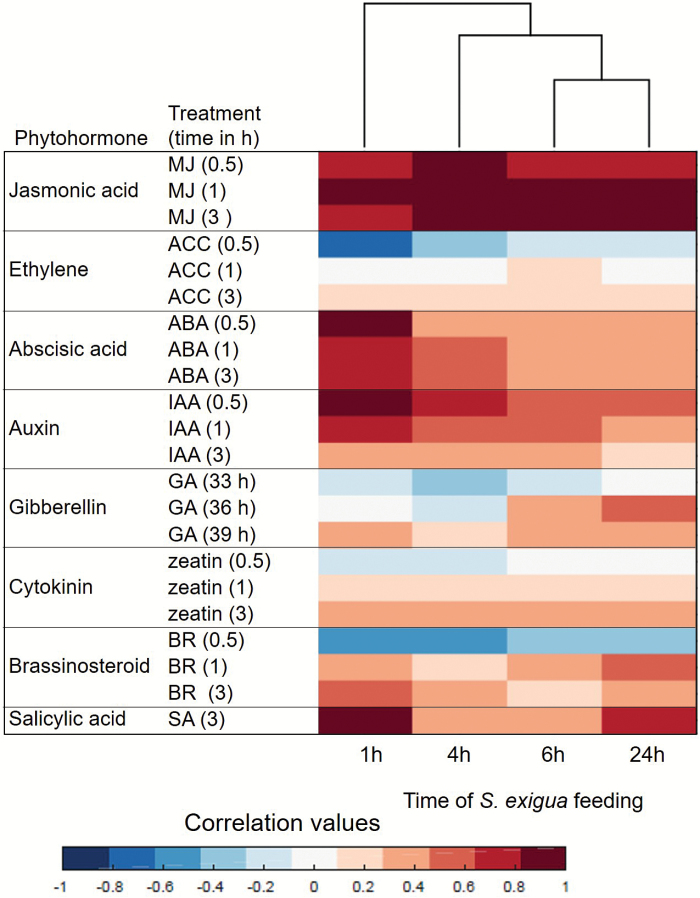
Plant hormone signatures based on transcriptomic data generated after S. exigua feeding on maize leaves. Red indicates a positive correlation between the maize S. exigua caterpillar treatment and a particular hormonal response; blue indicates a negative correlation. ABA, abscisic acid; ACC, 1-aminocyclopropane-1-caroxylic acid (precursor of ethylene); BR, brassinosteroid; GA, gibberelic acid; IAA, indole-3-acetic acid; MJ, methyl jasmonate; SA, salicylic acid. The analysis was conducted using the Hormonometer tool (Volodarsky et al., 2009). (This figure is available in color at JXB online.)